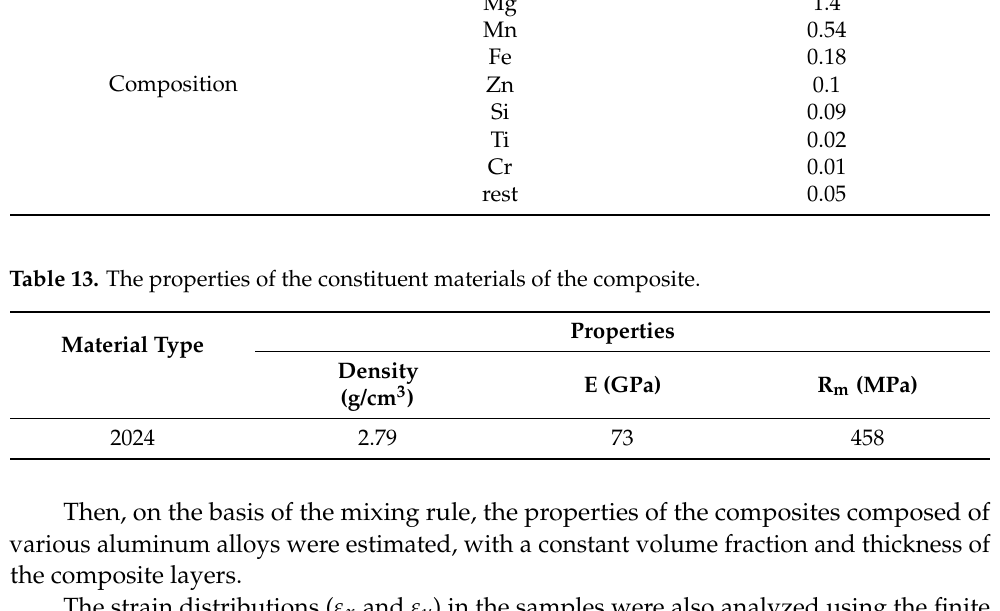
Table 14. Moulder dimensions.